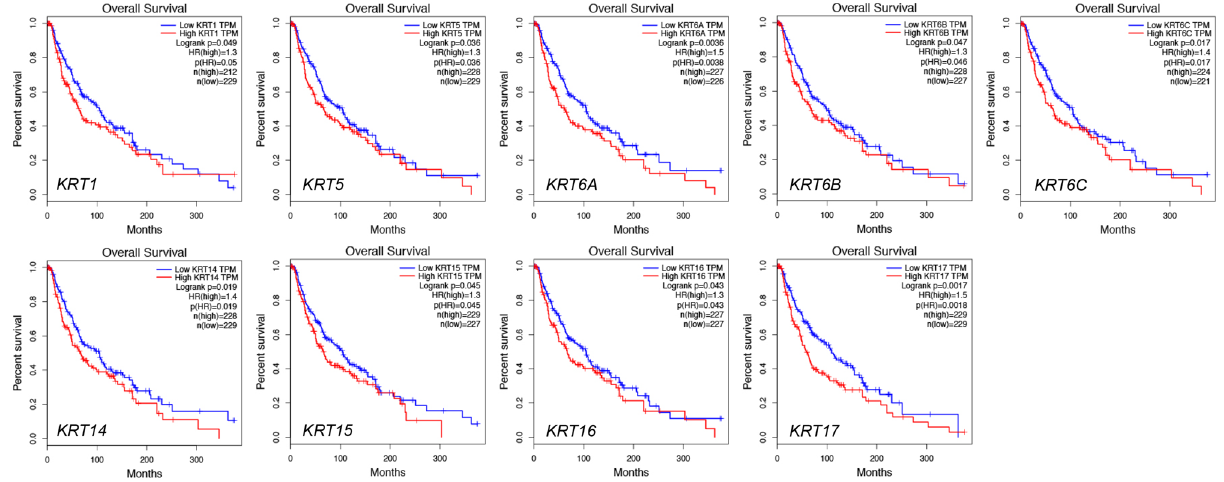
Figure 4. Kaplan–Meier survival analyses on differential KRTs expression groups with OS in the TCGA SKCM patients. High expression of KRT1/5/6/14/15/16/17 were significantly correlated with poor OS.